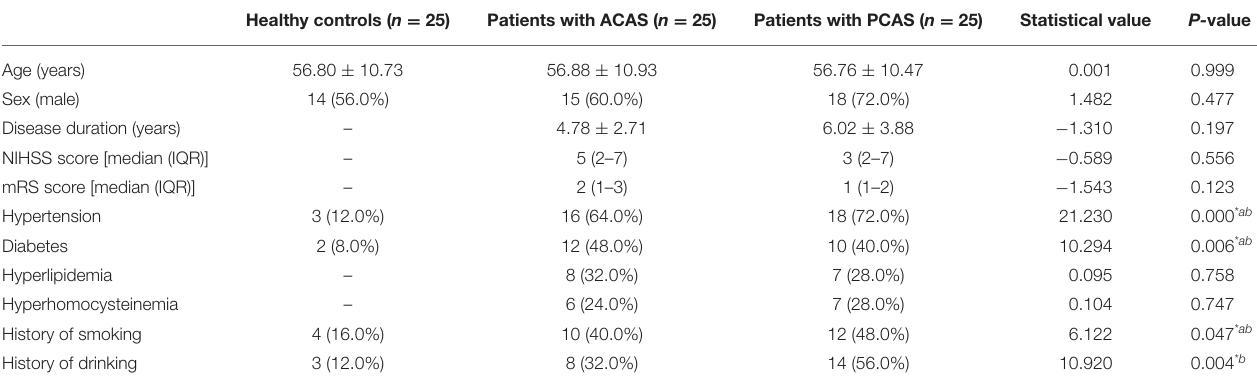
TABLE 1 | Demographic and clinical characteristics of all participants. Healthy controls ( n = 25) Patients with ACAS ( n = 25) Patients with PCAS ( n =